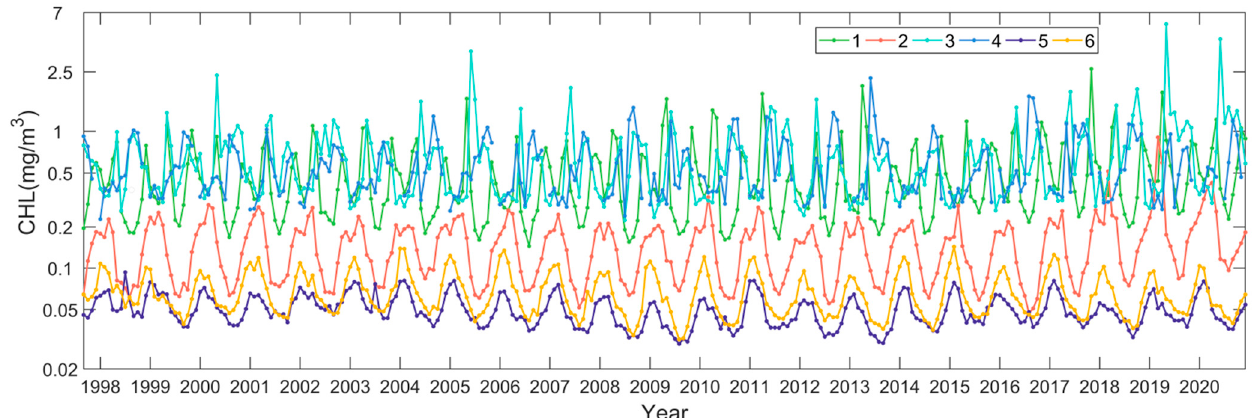
Figure 6. Interannual data time series of Chl-a in the six subregions in the northwest Pacific (see Figure 5 for the specified locations).